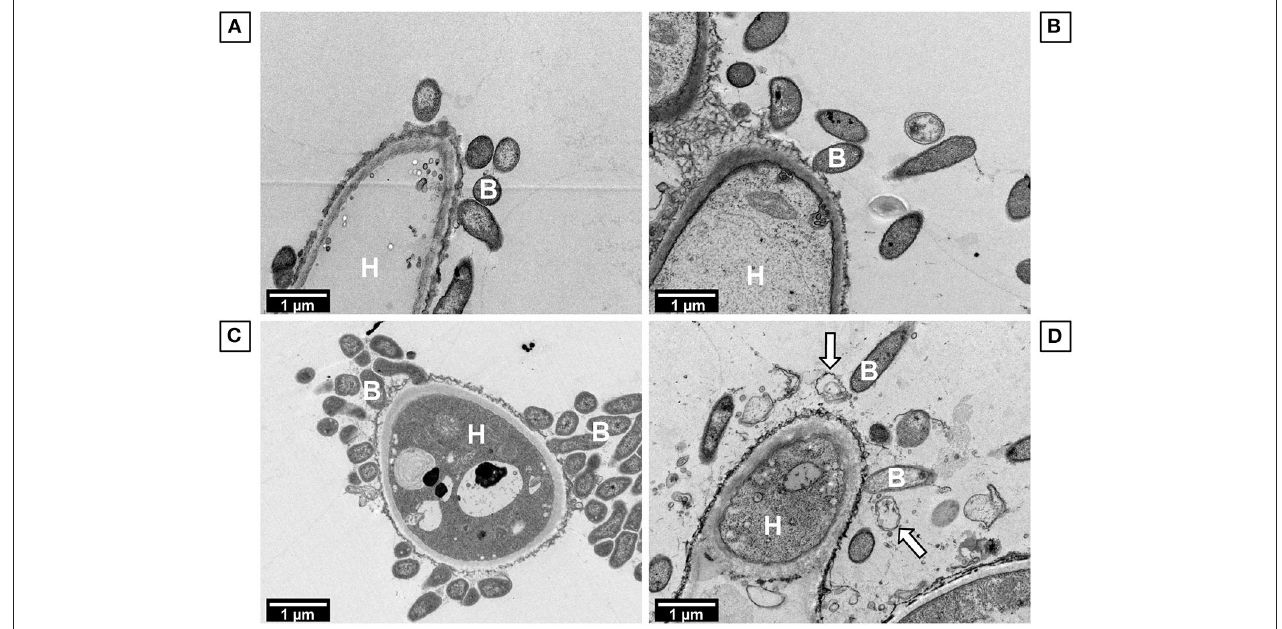
FIGURE 7 | TEM observations of A. fumigatus - S. maltophilia biofilms exposed to levofloxacin. (A) AF_REF + SM_REF untreated biofilm. (B) AF_REF + SM_REF biofilm treated with 8 µ g/mL LVX. (C) AF_CF + SM_CF untreated biofilm. (D) AF_CF + SM_CF biofilm treated with 8 µ g/mL LVX. H, hypha; B, bacteria. The white arrows show damages to bacterial cells.